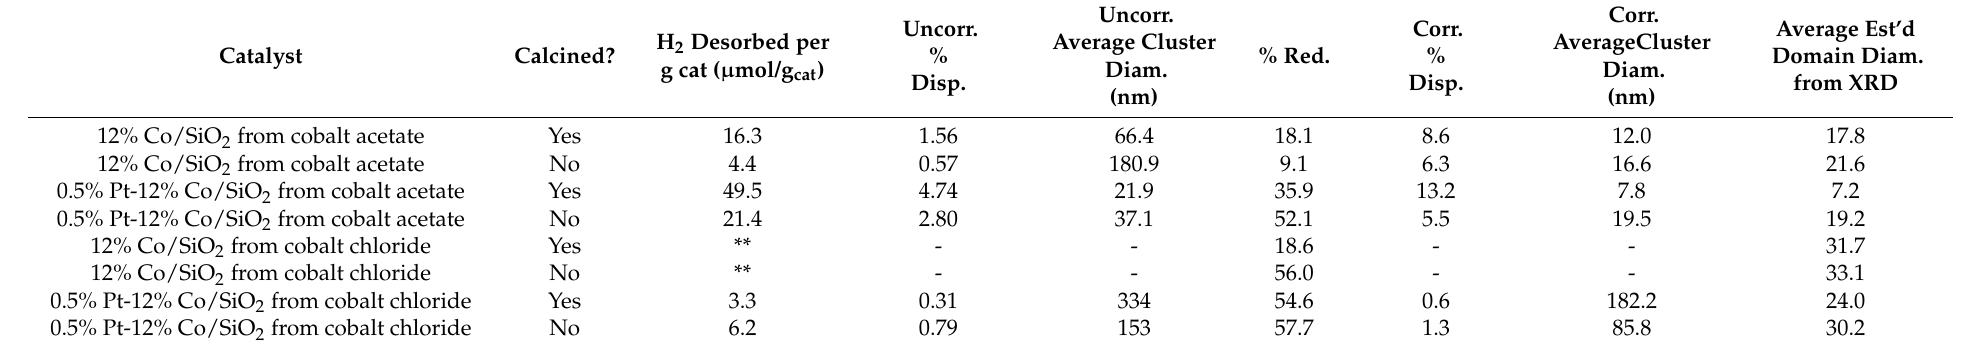
Table 3. Results of hydrogen chemisorption, pulse reoxidation, and X-ray diffraction. ** Positive peak in the TCD signal indicates the desorption of a Cl compound (e.g., HCl).